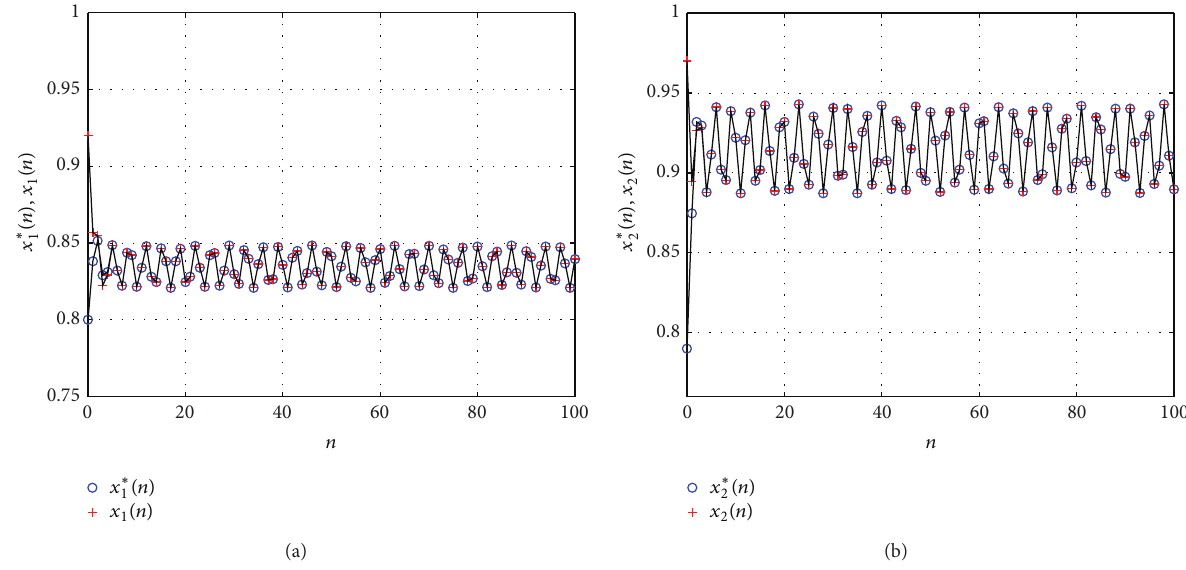
(−2) = 0.85 , 𝑥 ∗ (−1) = 0.80 , and 2 2